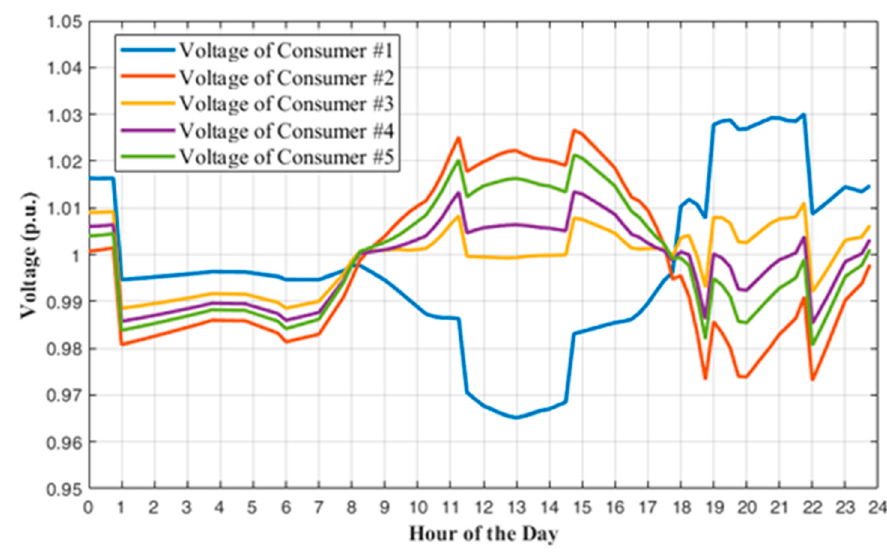
Figure 14. Voltage profile at consumer premises with the CVC.